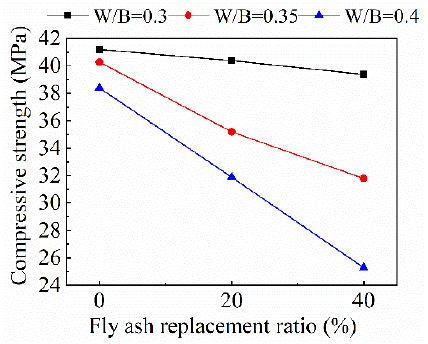
Figure 5. Variation of recycled mortar compressive strength with fly ash replacement ratio.